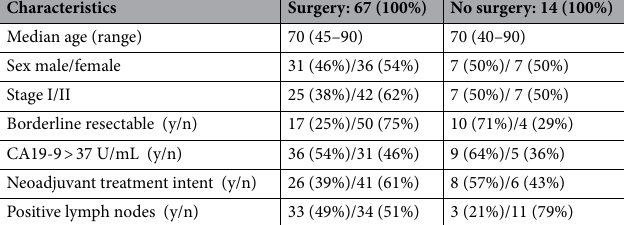
Table 2. Clinical demographics of localized pancreatic cancer